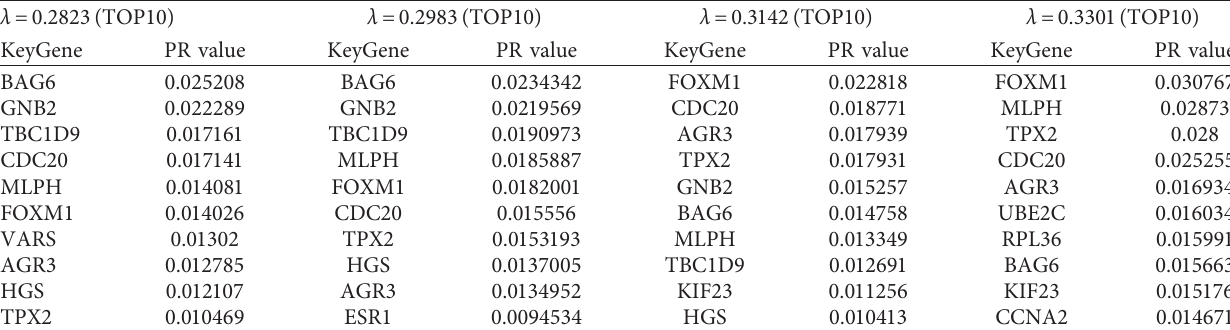
Table 2: TOP gene and PR values with different thresholds under the PageRank algorithm. λ �